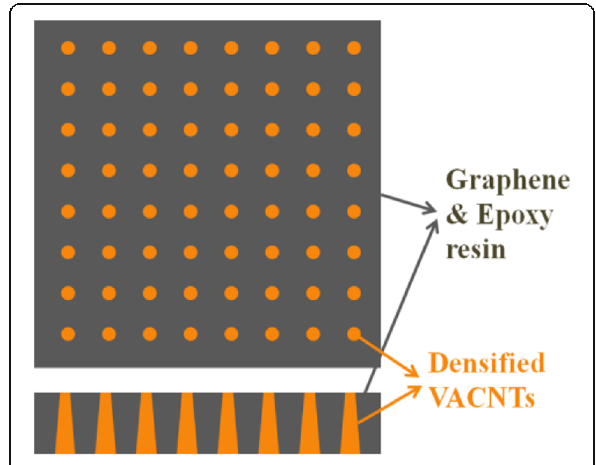
Fig. 1 Schematic diagram of the VACNTs/graphene composite film